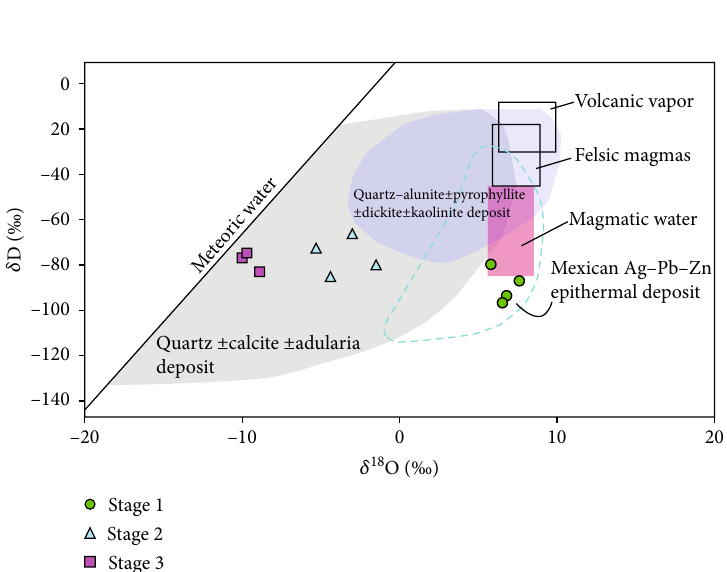
Figure 9: δ D and calculated δ 18 O values for ore fl uids of the Longmendian and other epithermal deposits (modi fi ed from [29 –